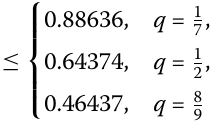
, 1 , 8 in Example 7 2 9